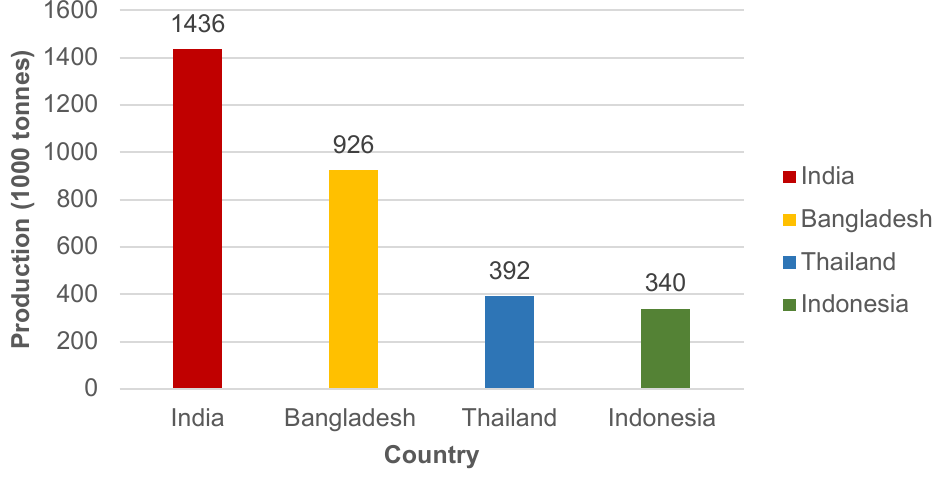
Figure 1. Top countries for jackfruit production. Data from [8].